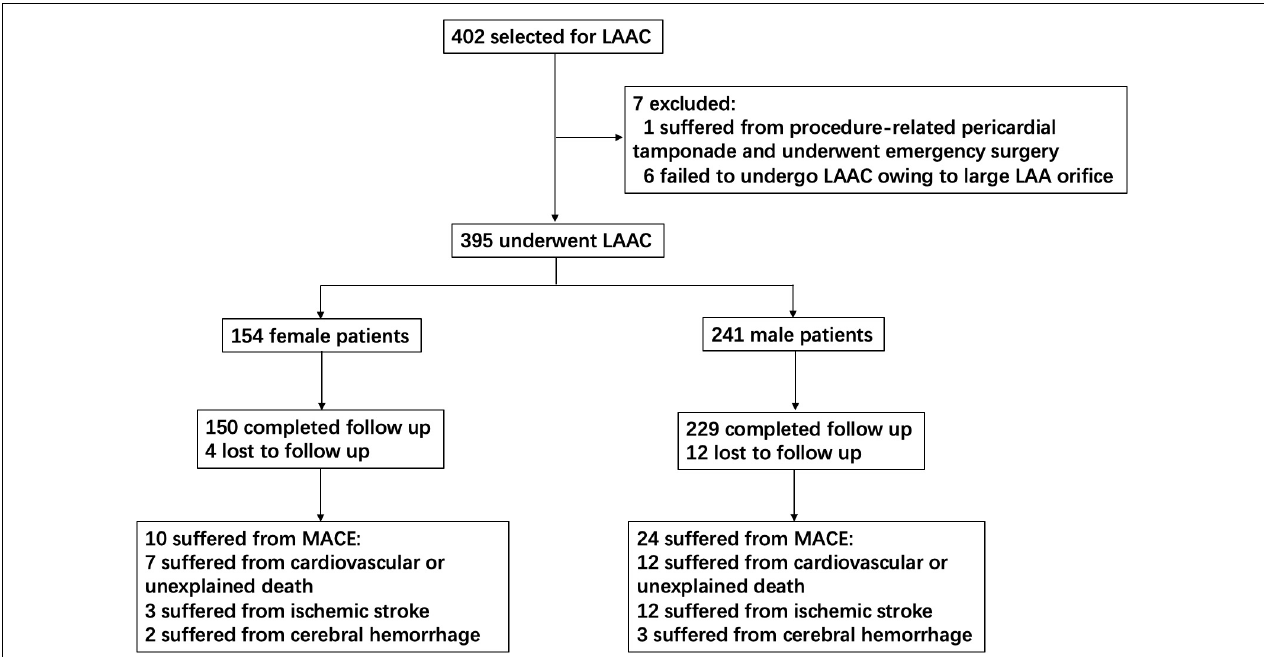
FIGURE 1 | Study flow diagram. This chart showed patients flow regarding enrollment, follow-up, and MACE assessed for the study. LAAC, left atrial appendage closure; MACE, major adverse cardiovascular